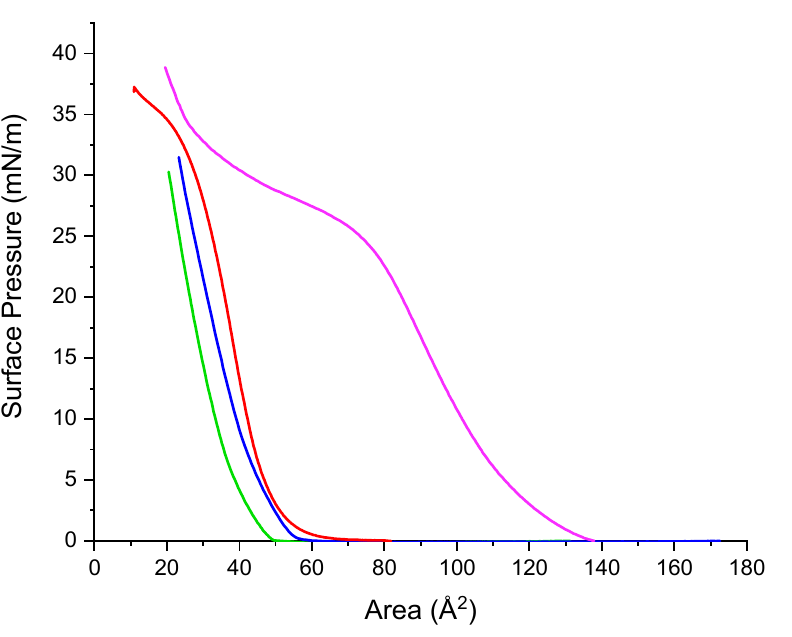
Figure 12. Surface pressure isotherms of zein and arginine-based Gemini surfactants. Zein (red line), C 3 (LA) 2 (blue line), C 6 (LA) 2 (green line), C 9 (LA) 2 (purple line). For Gemini the area corresponds to molecular area, for zein the area corresponds to the area per amino acid residue.